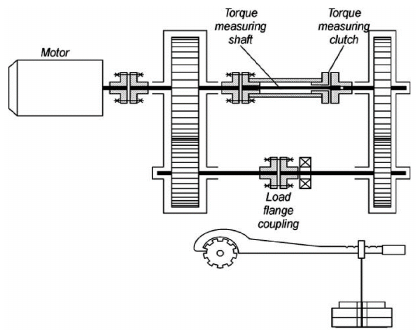
Figure 3. Layout of the FZG gear test rig [4].